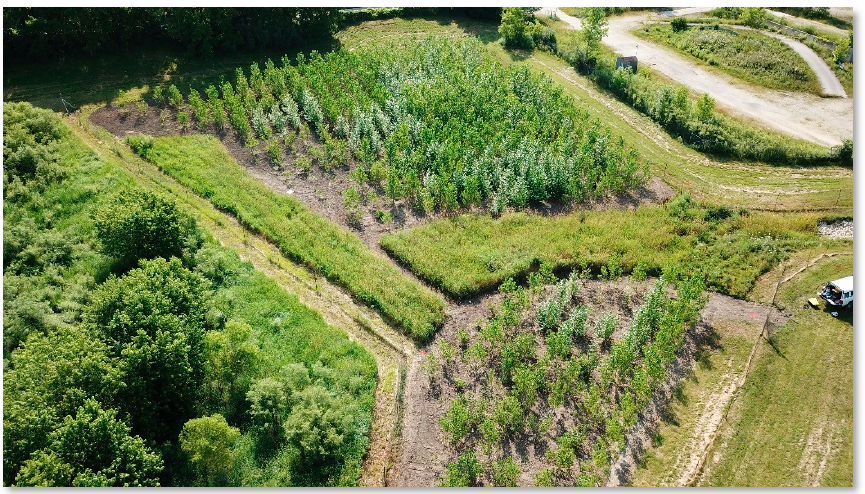
Figure 2. Poplar phytoremediation buffer system in the Great Lakes Basin, United States. From Zalesny et al. [5]. Photo courtesy of Paul Manley, Missouri University of Science and Technology. Pilipovi ć et al. [6] studied hybrid poplars at the phytoremediation buffer systems (i.e.,